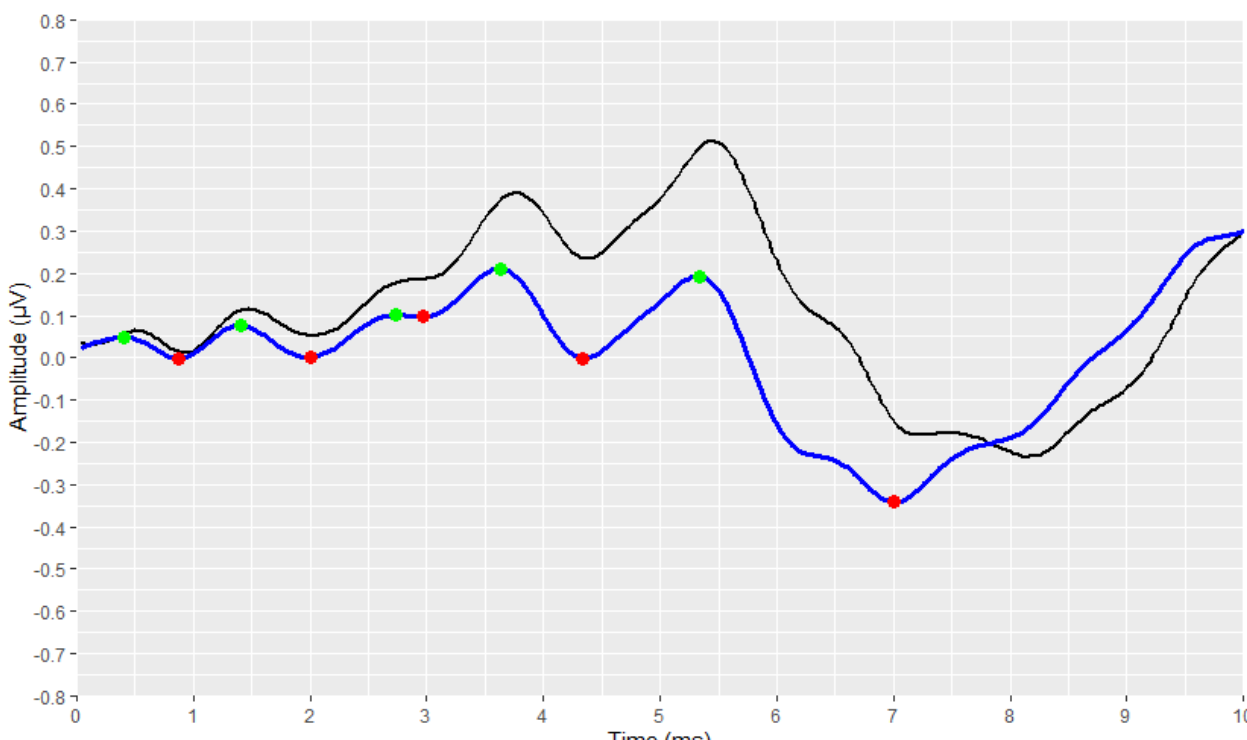
Figure 7. Detection of all local extremes (peaks in green, troughs in red) of the filtered AMLR signal (raw signal is depicted in black and filtered signal is depicted in dark red).